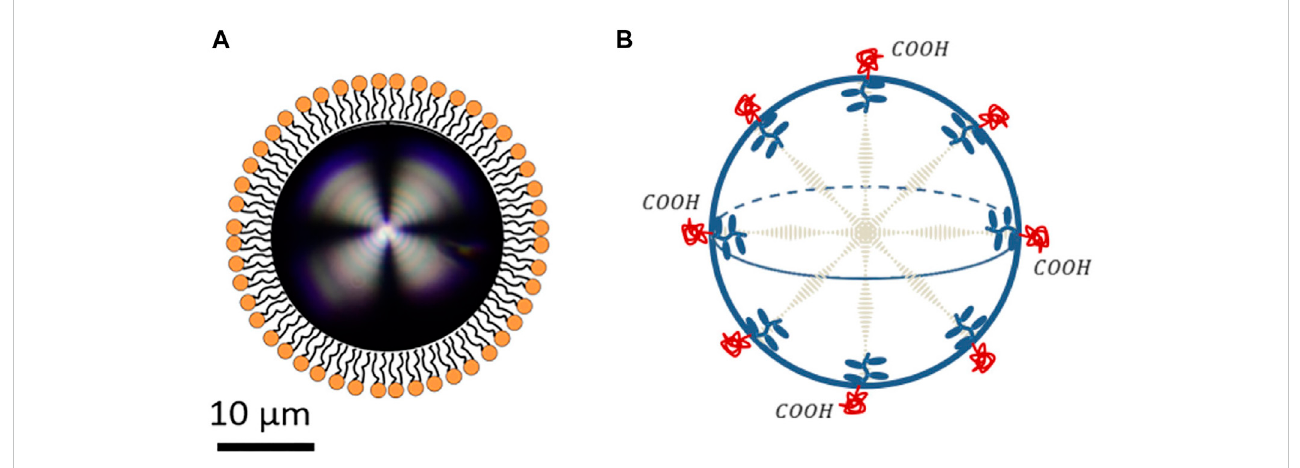
FIGURE 10 Some examples of elastic anisotropic droplets. (A) Phospholipid-coated liquid crystal droplet. (B) pH-sensitive cholesteric liquid crystal droplet. (A) is reproduced under CC-BY-4.0 (Paterson et al., 2020). (B) Is reprinted with permission from (Lee et al., 2016). Copyright 2016, American Chemical